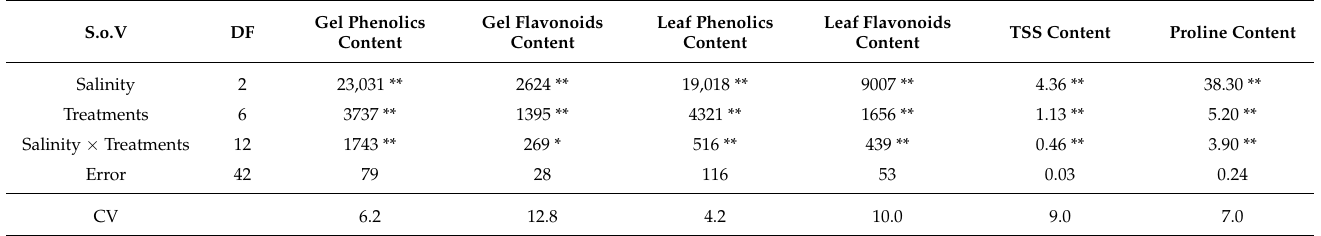
Table 3. ANOVA for the effects of salinity and foliar applications (without spraying, potassium nitrate, Zn, and Fe nanoparticles) on the gel and leaf phenolics, gel and leaf flavonoids, TSS, and proline content of Aloe vera